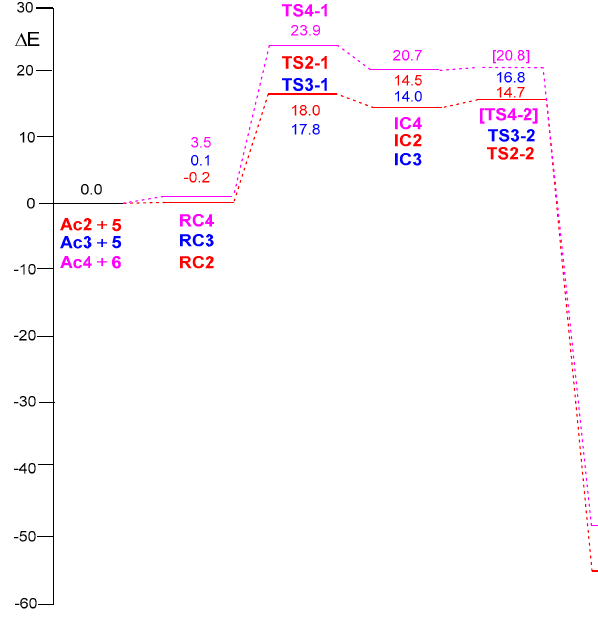
Figure 11. Energy profiles (in kcal/mol) of the most favorable regioisomeric reaction paths associated with the AgAAC reactions of Ac2 (in red) and Ac3 (in blue) with 5 , and that of Ac4 (in pink) with 6 .